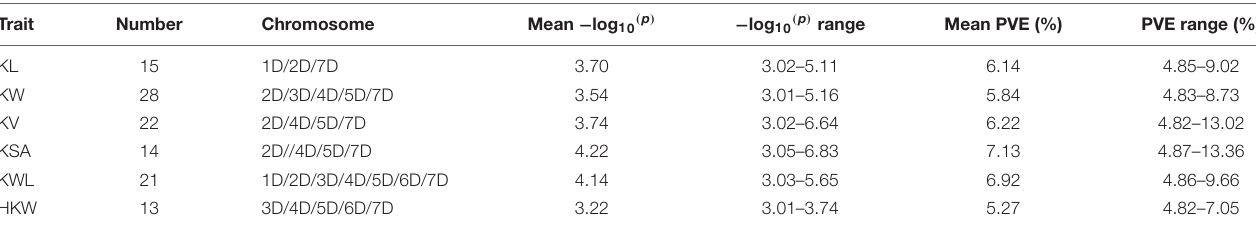
TABLE 4 | Significant SNP markers identified for six kernel-related traits by genome-wide association study based on best linear unbiased prediction (BLUP) values. Trait